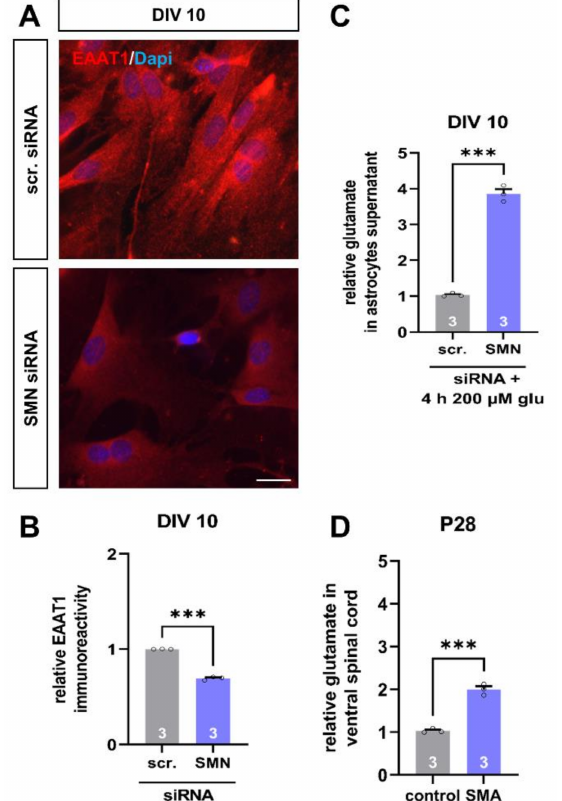
Figure 5. SMN-deficient spinal astrocytes show a reduction in EAAT1 protein level and reduced uptake of glutamate. ( A ) Immunostaining of wild-type astrocyte cultures transfected with scrambled (scr.) or SMN siRNA against EAAT1 protein (green) at DIV 10. In addition, nuclear DNA was stained with Dapi (blue). ( B ) SMN-deficient spinal astrocytes showed reduced protein levels of EAAT1, compared to astrocytes transfected with scrambled siRNA (***, p < 0.001). ( C ) When astrocytes were exposed to 200 µ M of glutamate (glu) for 4 h, SMN-deficient astrocytes showed reduced uptake of the transmitter, compared to astrocytes transfected with scrambled siRNA (***, p < 0.001). ( D ) Ventral horn spinal cord tissue of juvenile SMA type III mouse model showed an increased glutamate level at P28, compared to control animals (***, p < 0.001). n = 3 independent experiments for immunostaining (see bars). For each experiment > 50 cells were analyzed. n = 3 independent experiments